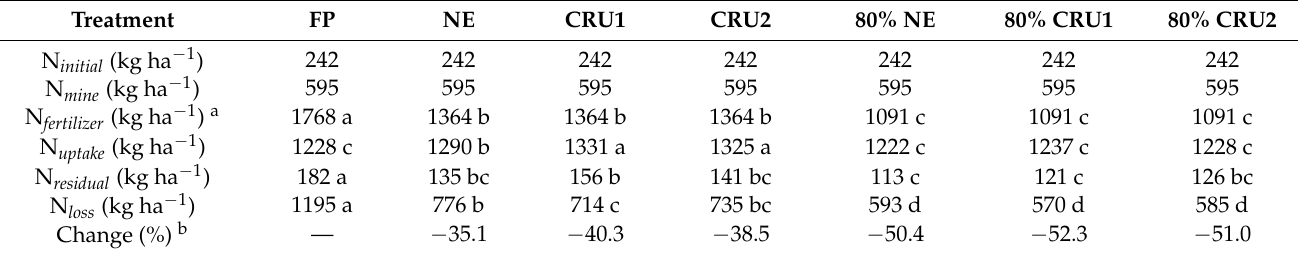
Table 6. Nitrogen balance in different fertilizer treatments averaged over four growing seasons in a wheat–maize rotation from June 2015 to June 2019 in north-central China. Treatment FP